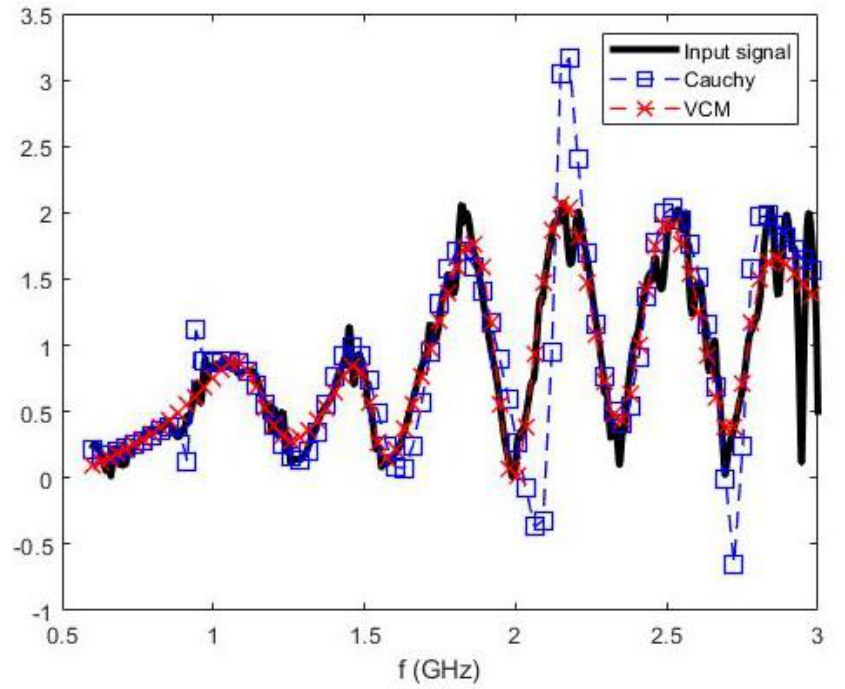
Figure 6. Frequency domain backscattered signal obtained from a metal cylinder in free space at 60